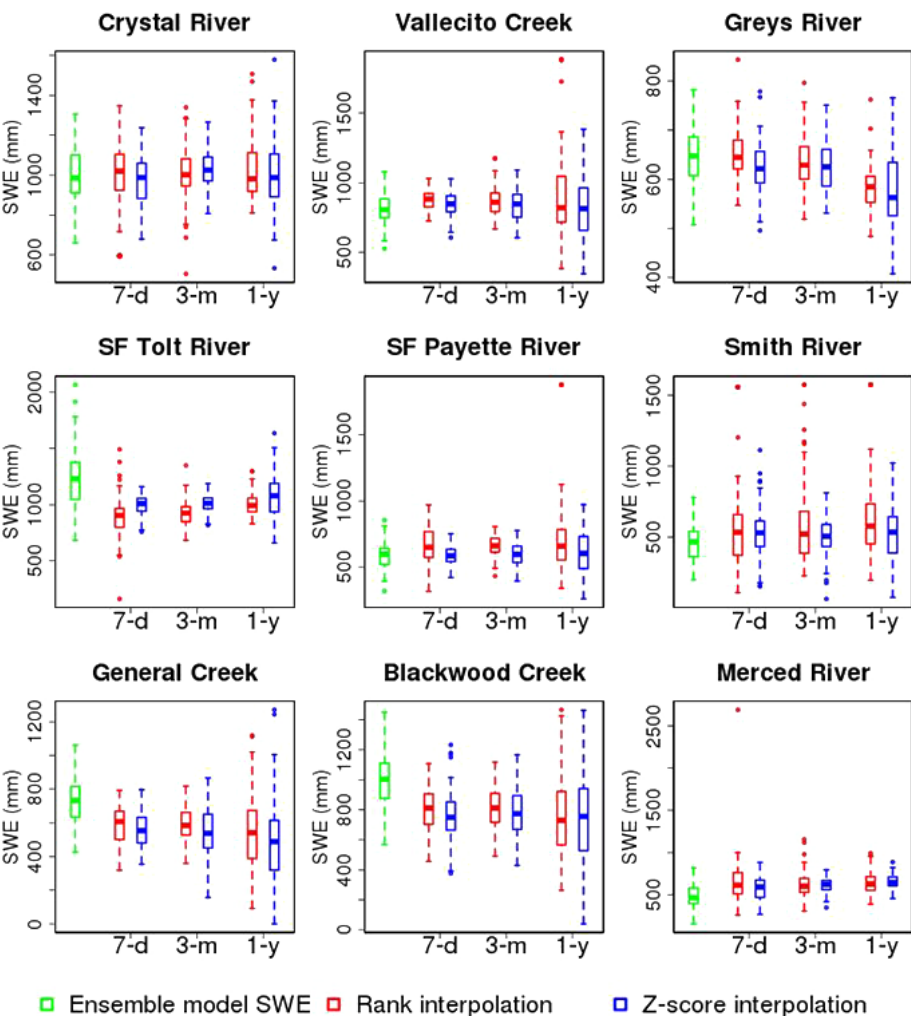
Figure 2. Box plots of ensemble model SWE and estimated ensemble SWE observations for the nine case basins on the data assimilation date in 2004 for three window lengths – 7 days (7-d), 3 months (3-m), and 1 year